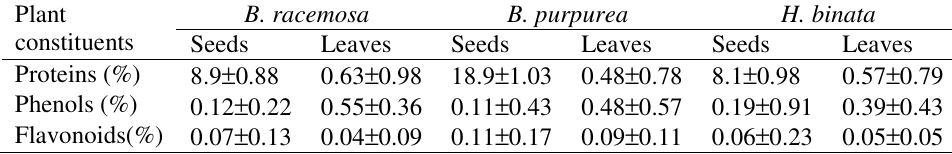
Table-4 . Data of quantitative estimation of proteins, phenols and